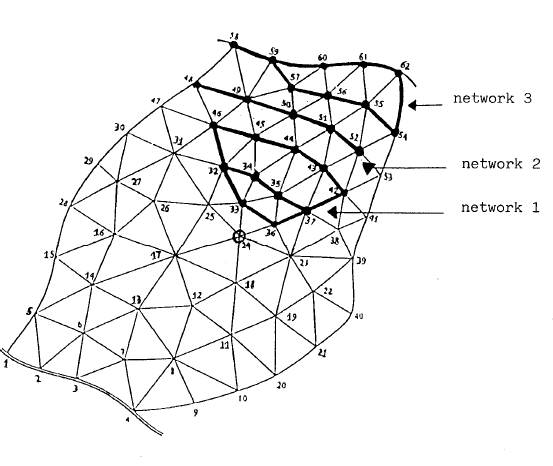
Fig. 4.9.Aquifer configuration and finite element discretization of the